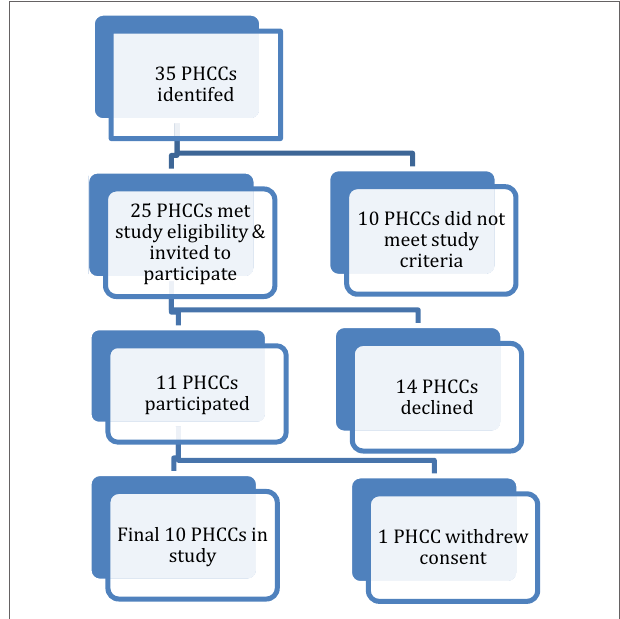
FigUre 1 | Primary health care center (PHCC) study recruitment